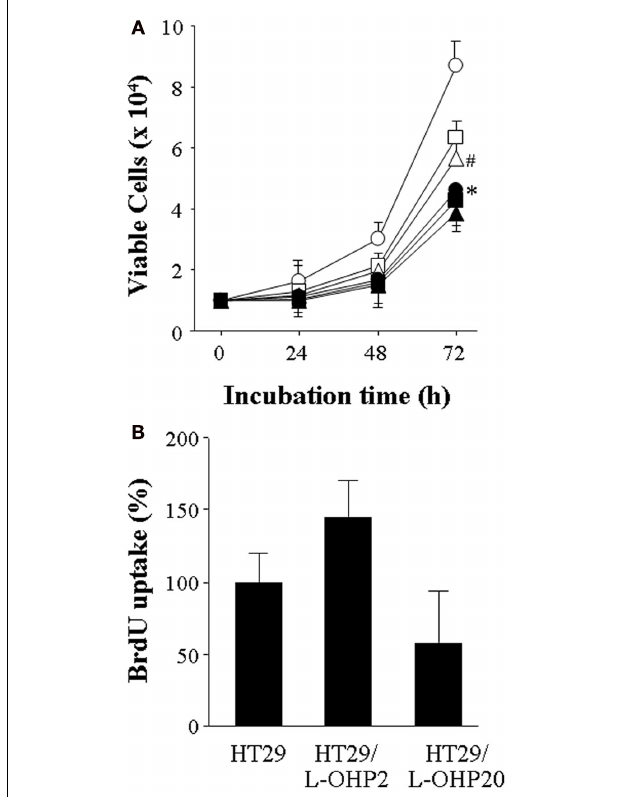
FIGURE 4 |Alteration in proliferation (A) and DNA replication potential (B) of HT29 cells by gain of resistance to L-OHP. (A) HT29/L-OHP20 (closed symbols) and the parental cells (open symbols) were cultured in the presence of 0 (circles), 5 (squares), or 20 μ M PHPC (triangles), and their viable cell numbers were evaluated as described in Figure 2 . Significant • difference ( p < 0.05) for HT29/L-OHP20 cells with 0 μ M ( )* or the parental Δ ◦ cells with 20 μ M PHPC ( ) # from the parental cells without PHPC ( ). (B) Uptake of 5-bromo-2 (cid:2) -deoxyuridine (BrdU) into DNAs in the parental (HT29) and resistant (HT29/L-OHP2 and HT29/L-OHP20) cells was measured using a cell proliferation ELISA biotrak system (GE healthcare, Buckinghamshire, UK).Value is normalized to that in the parental cells (taken as 100%), and expressed as the mean ± SD of three independent experiments.